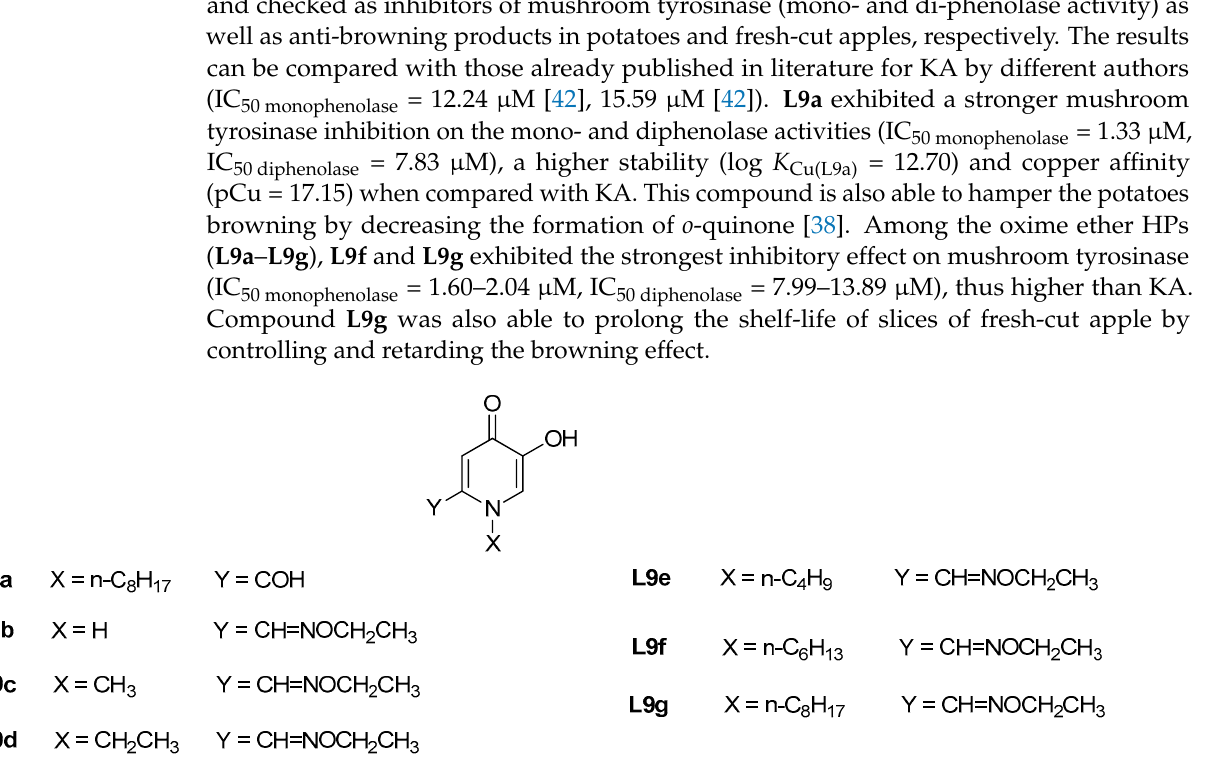
Figure 4. Mono-hydroxypyridinone ligands employed as tyrosinase inhibitors as anti-browning agents in fruits and vegetables.